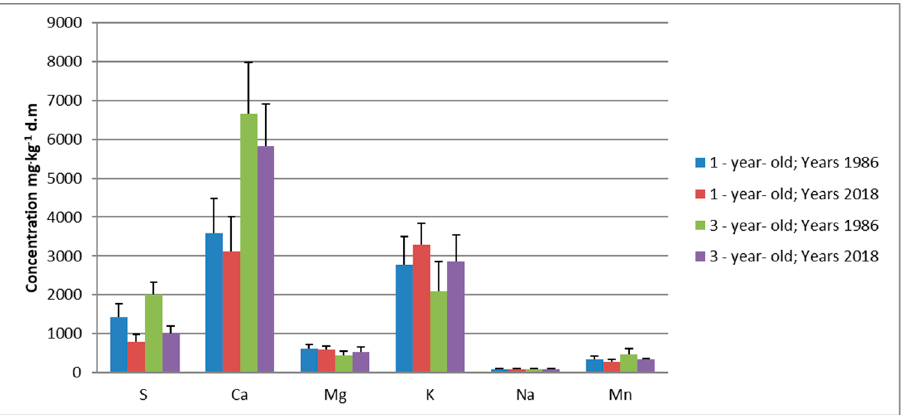
Figure 4. The contents of selected macronutrients in 1-year-old and 3-year-old silver fir needles in milligrams per kilogram of dry matter (mg · kg − 1 d.m) (mean values ± SD; n =